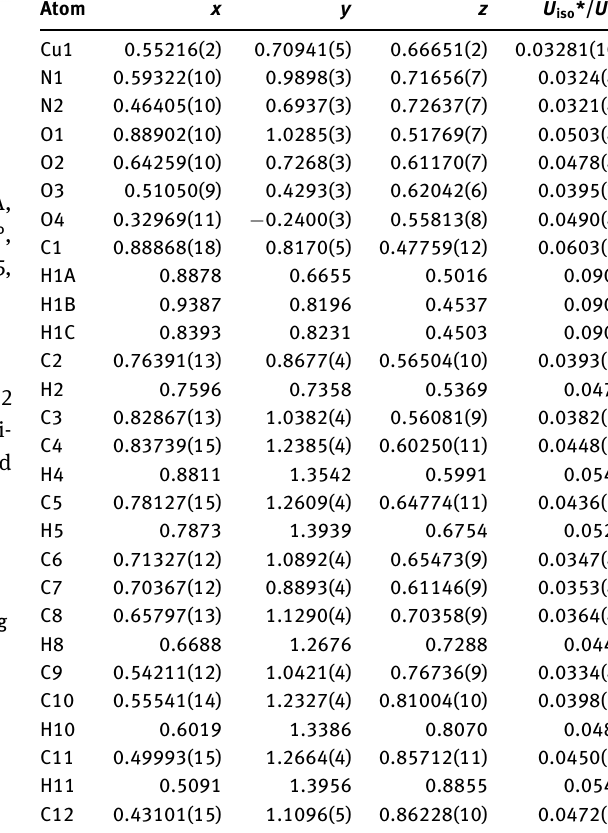
Table 2: Fractional atomic coordinates and isotropic or equivalent isotropic displacement parameters (Å 2